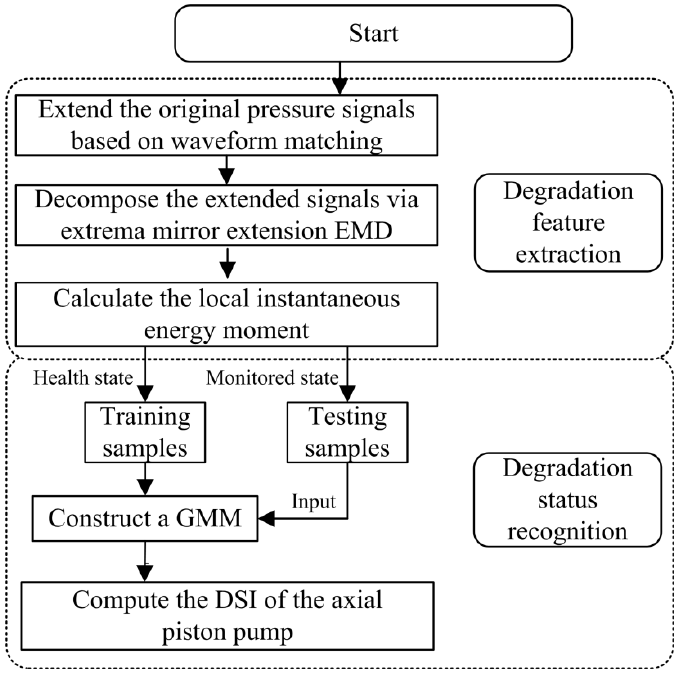
Figure 1. Overview of the degradation status identification method.